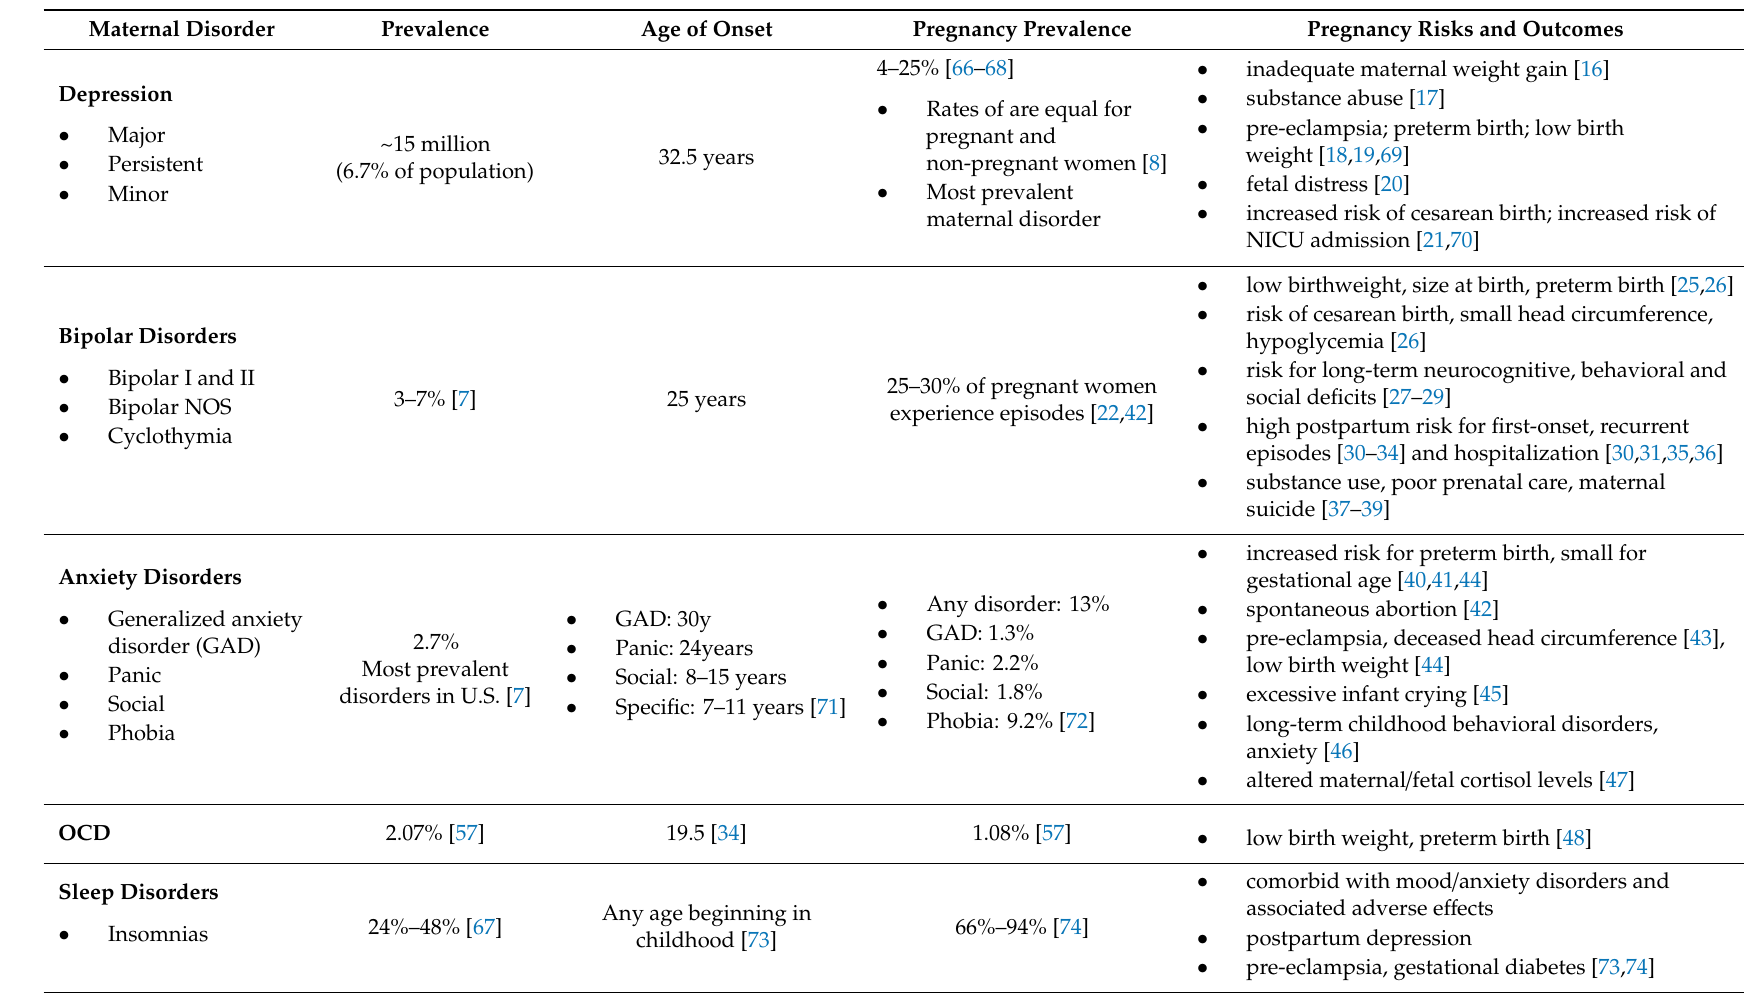
Table 2. Overall prevalence (U.S. data), average age of onset, prevalence rates, and risk experienced by pregnant